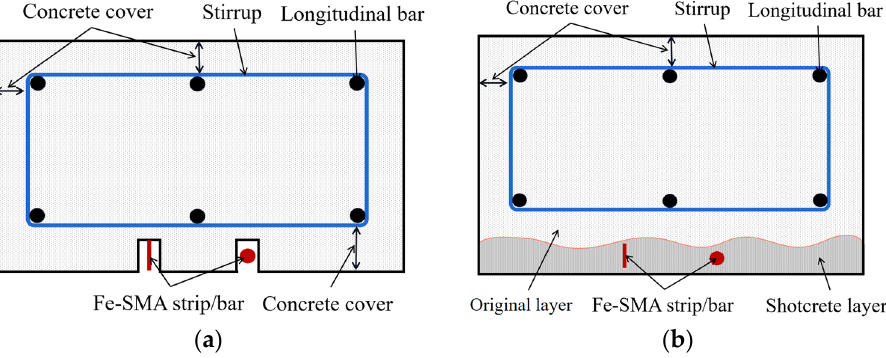
Figure 18. Internal installation modes: ( a ) NSM technology, ( b ) embedding Fe-SMA bars/strips.